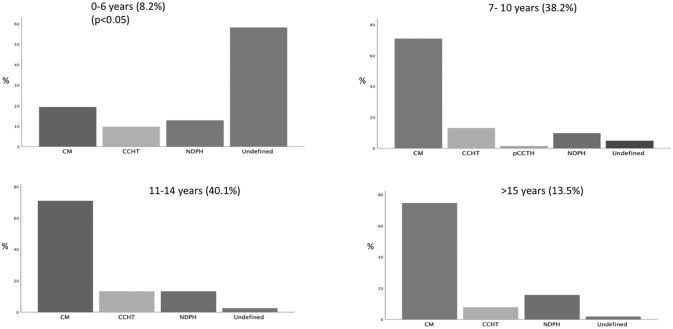
Distributions of headache subtypes (ICHD 3) in relation with age.